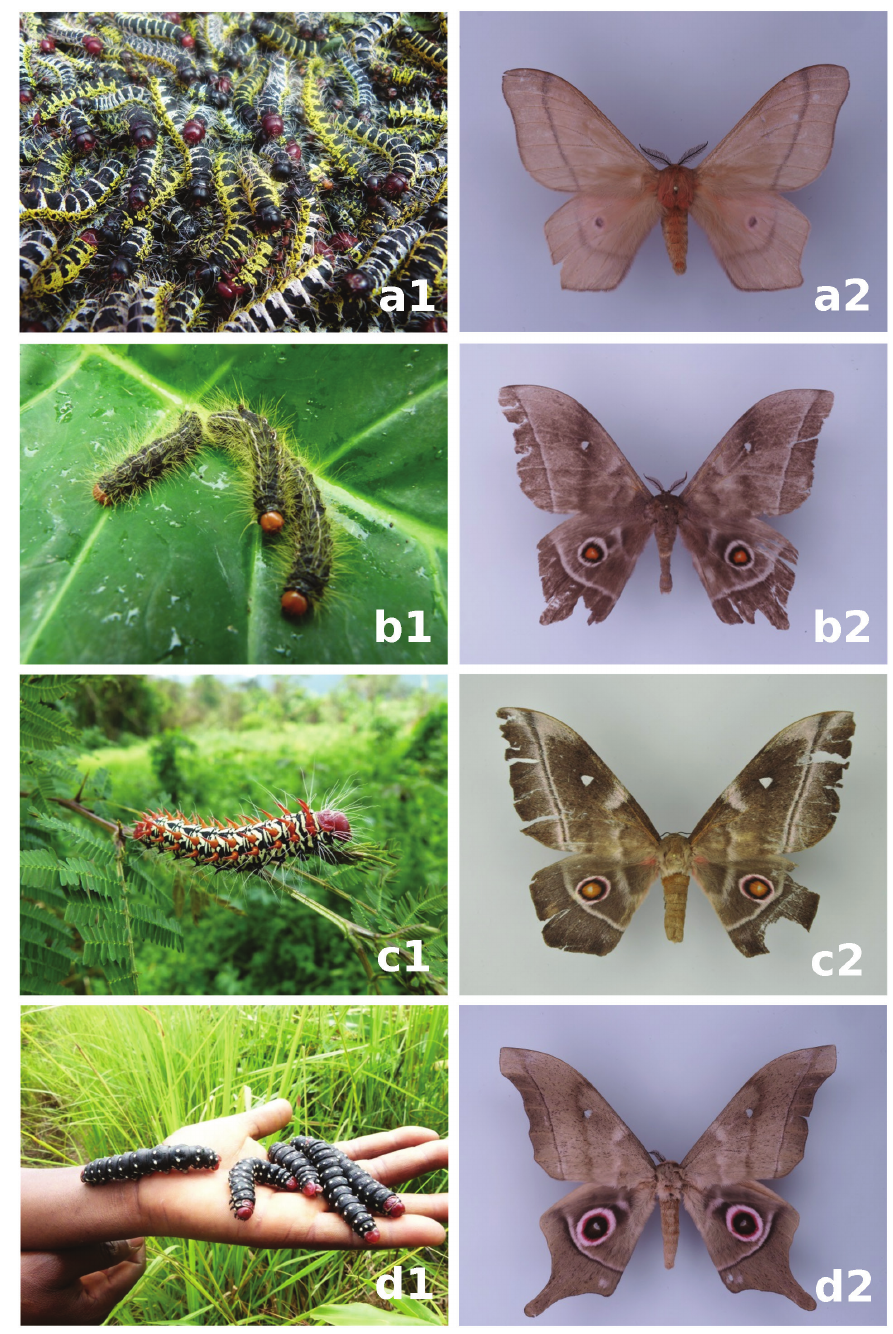
Figure 2. Photographs of 4 edible Saturniidae-larvae collected in the Province Uíge and its imagoes. a Cirina forda (1) larva, (2) male imago b Imbrasia epimethea (1) larva, (2) male imago c Imbrasia obscura (1) larva, (2) male imago d Imbrasia truncata (1) larva, (2) male imago